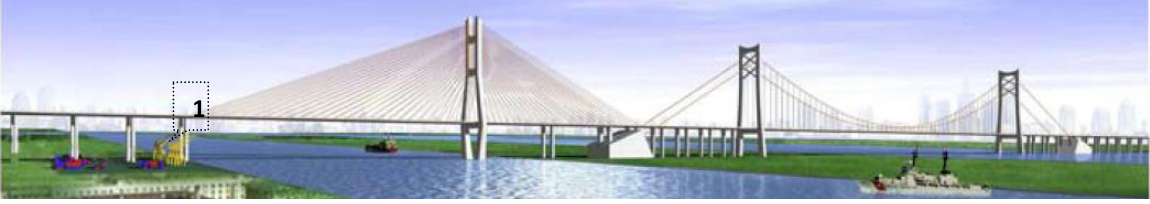
Figure 7. General view of the bridge and selection of the monitoring study